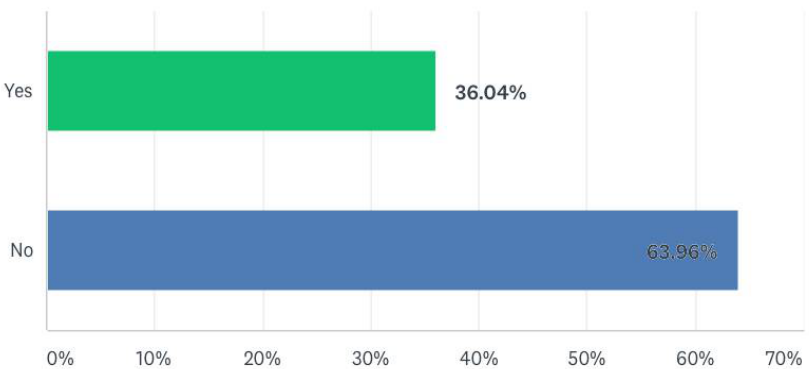
Figure 1. Previous Hawai’i experience. Note: responses to the question “Have you ever vacationed in Hawai’i before?”.